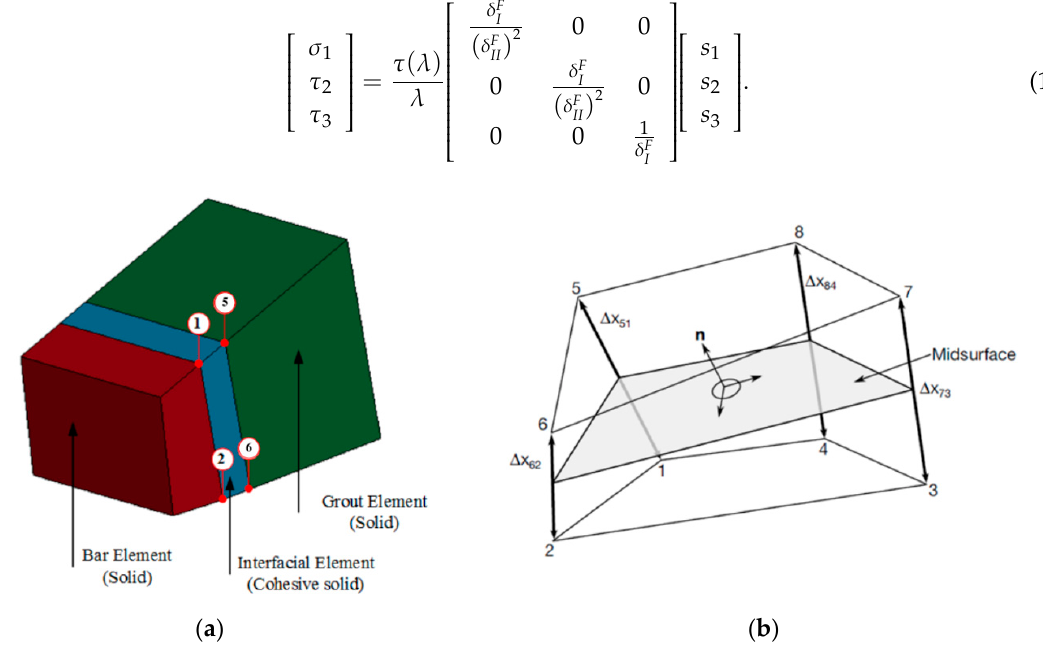
Figure 6. ( a ) Cohesive elements at bar–grout interface; ( b ) tractions at mid-surface of cohesive solid elements [42].